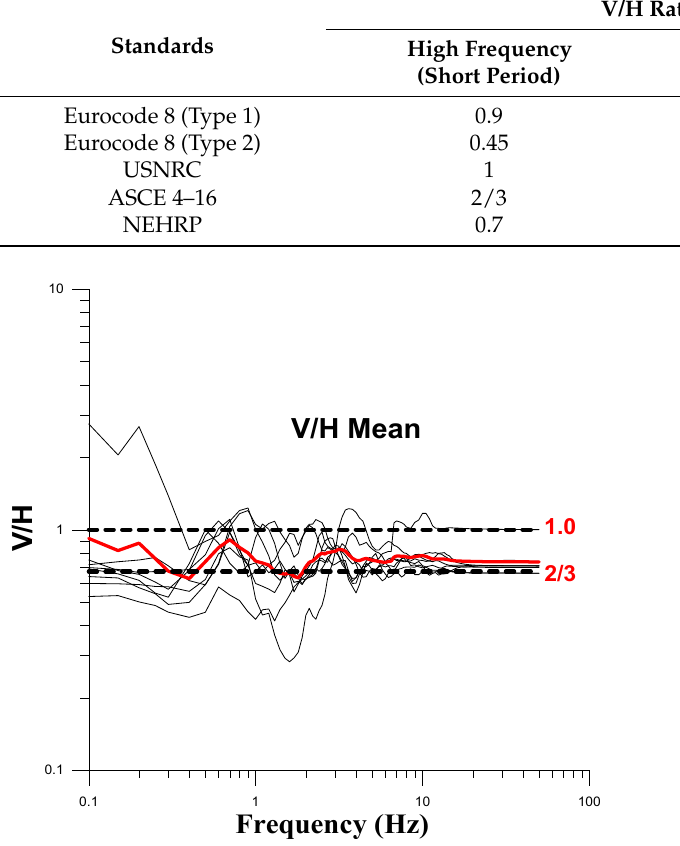
Figure 9. Mean and individual V/H ratios of the 8 seismic stations. The x -axis represents frequency and the y -axis the V/H ratios. Table 3. The vertical-to-horizontal (V/H) ratios of seismic standards.